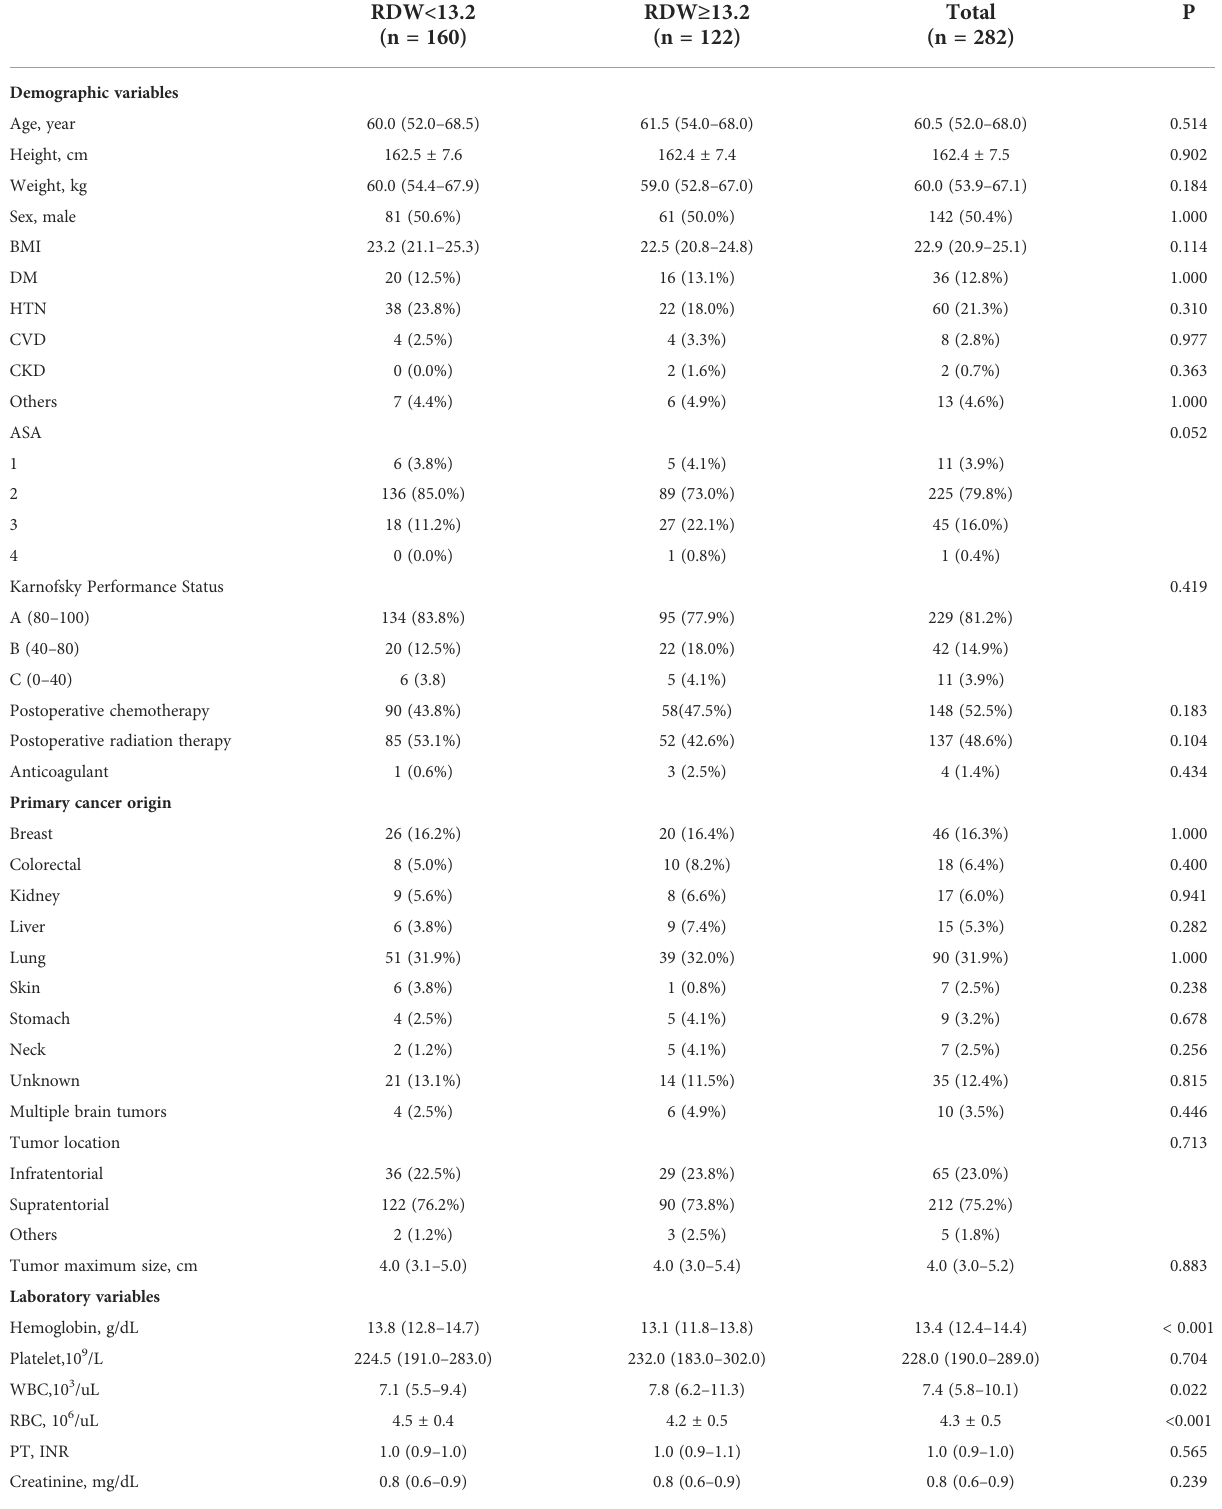
TABLE 1 Baseline characteristics and perioperative variables of the study